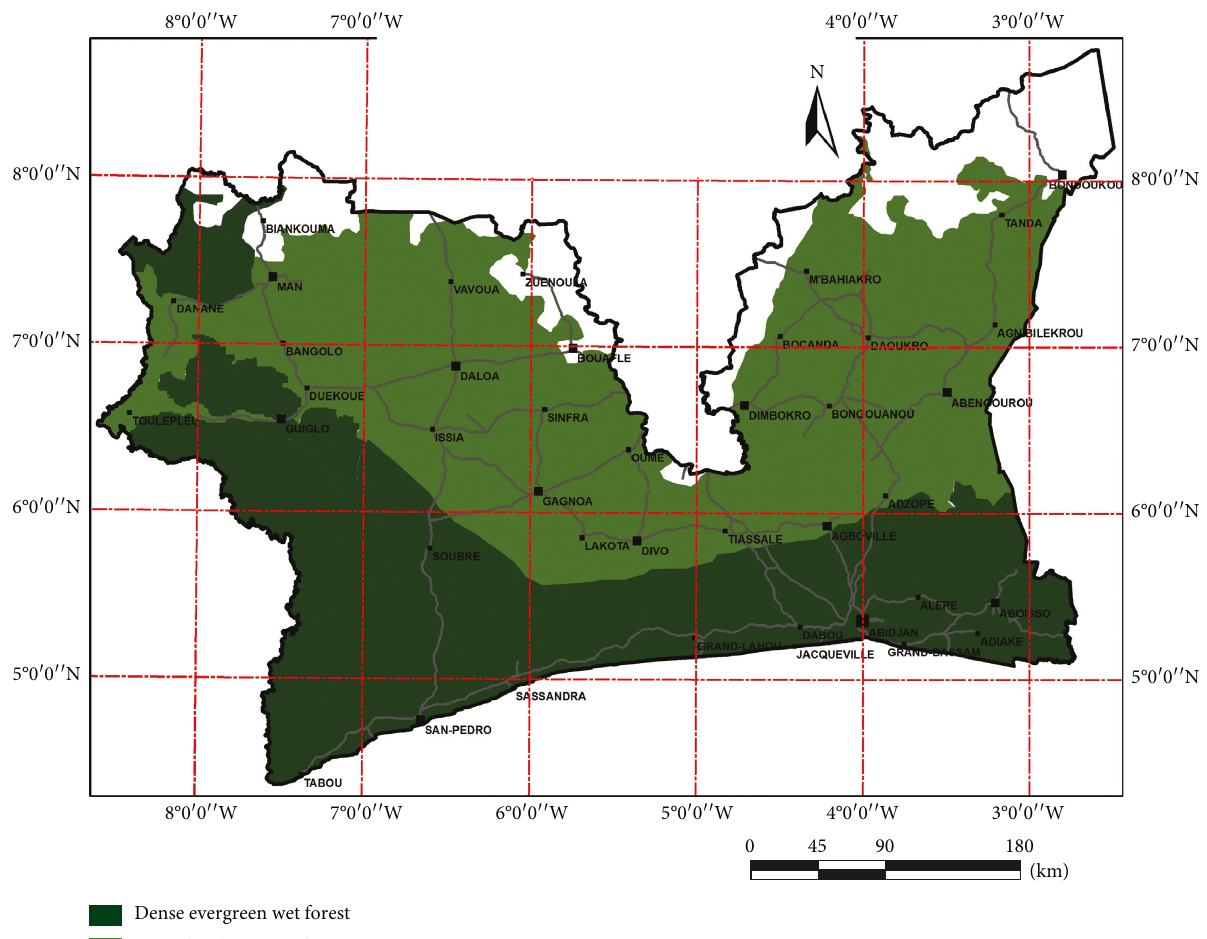
Figure 1: Vegetation types of the study area (adapted to Kon´e et al.